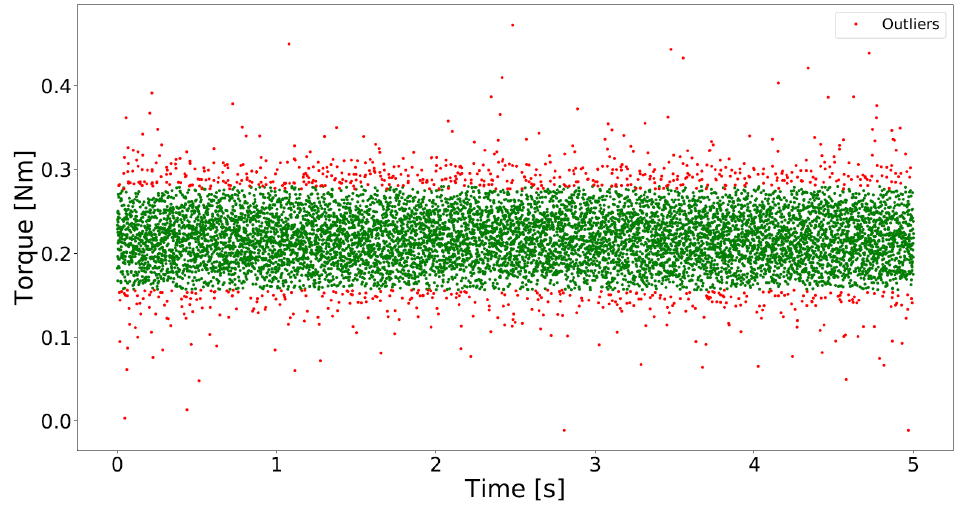
Figure 4. Ball bearing 61820 measured data for water at 2000 rpm after the outliers elimination.